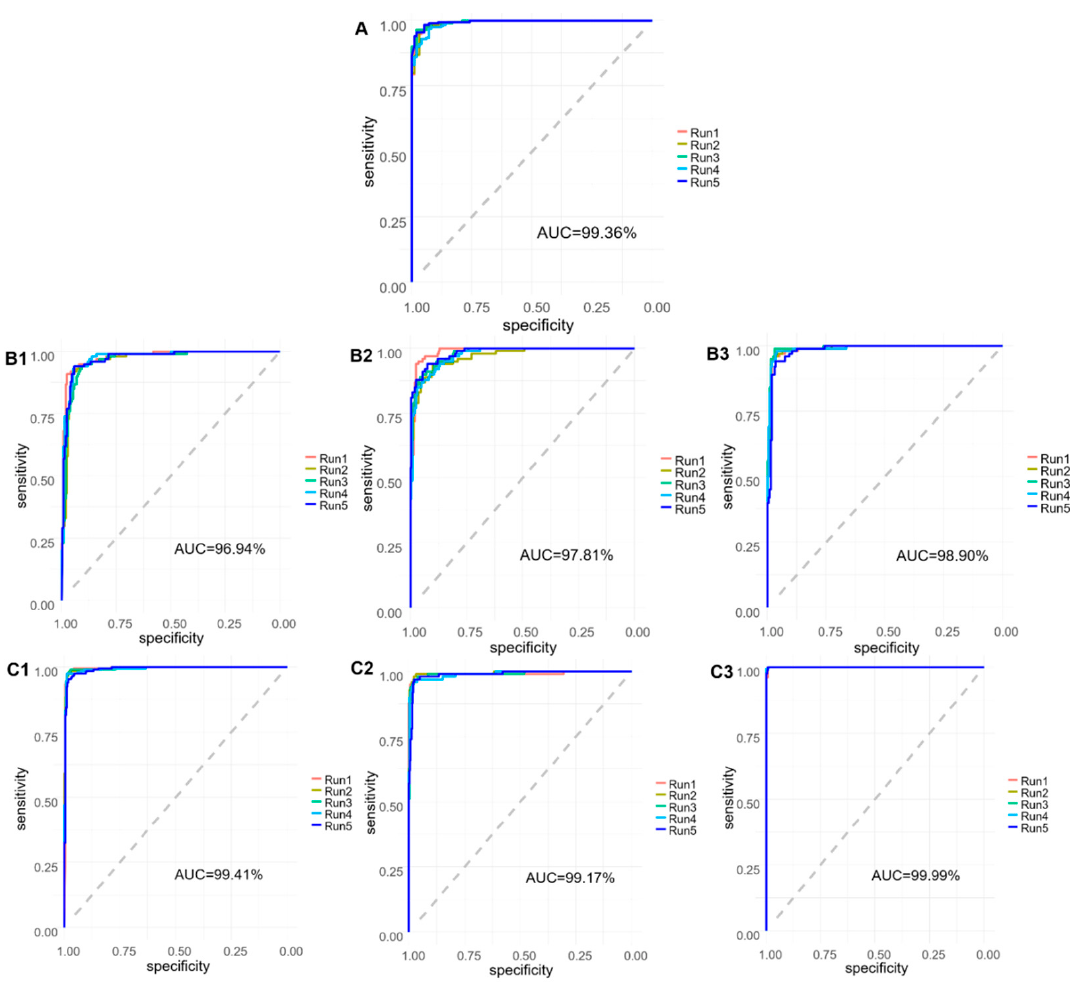
Figure 4. The calculated ROC curves using BLP prediction values of the ANN models for differentiating AD vs HC ( a ) in the binary model, and predictions from both tertiary models, which differentiates one class against all others. The AD tertiary model differentiates mild AD ( b1 ) vs moderate AD ( b2 ) versus HC ( b3 ). The OD tertiary model differentiates AD ( c1 ) vs HC ( c2 ) vs OD ( c3 ). AUC refers to area under ROC curve value calculated from the model predictions against the outcome that shows the efficacies of the ANN models.